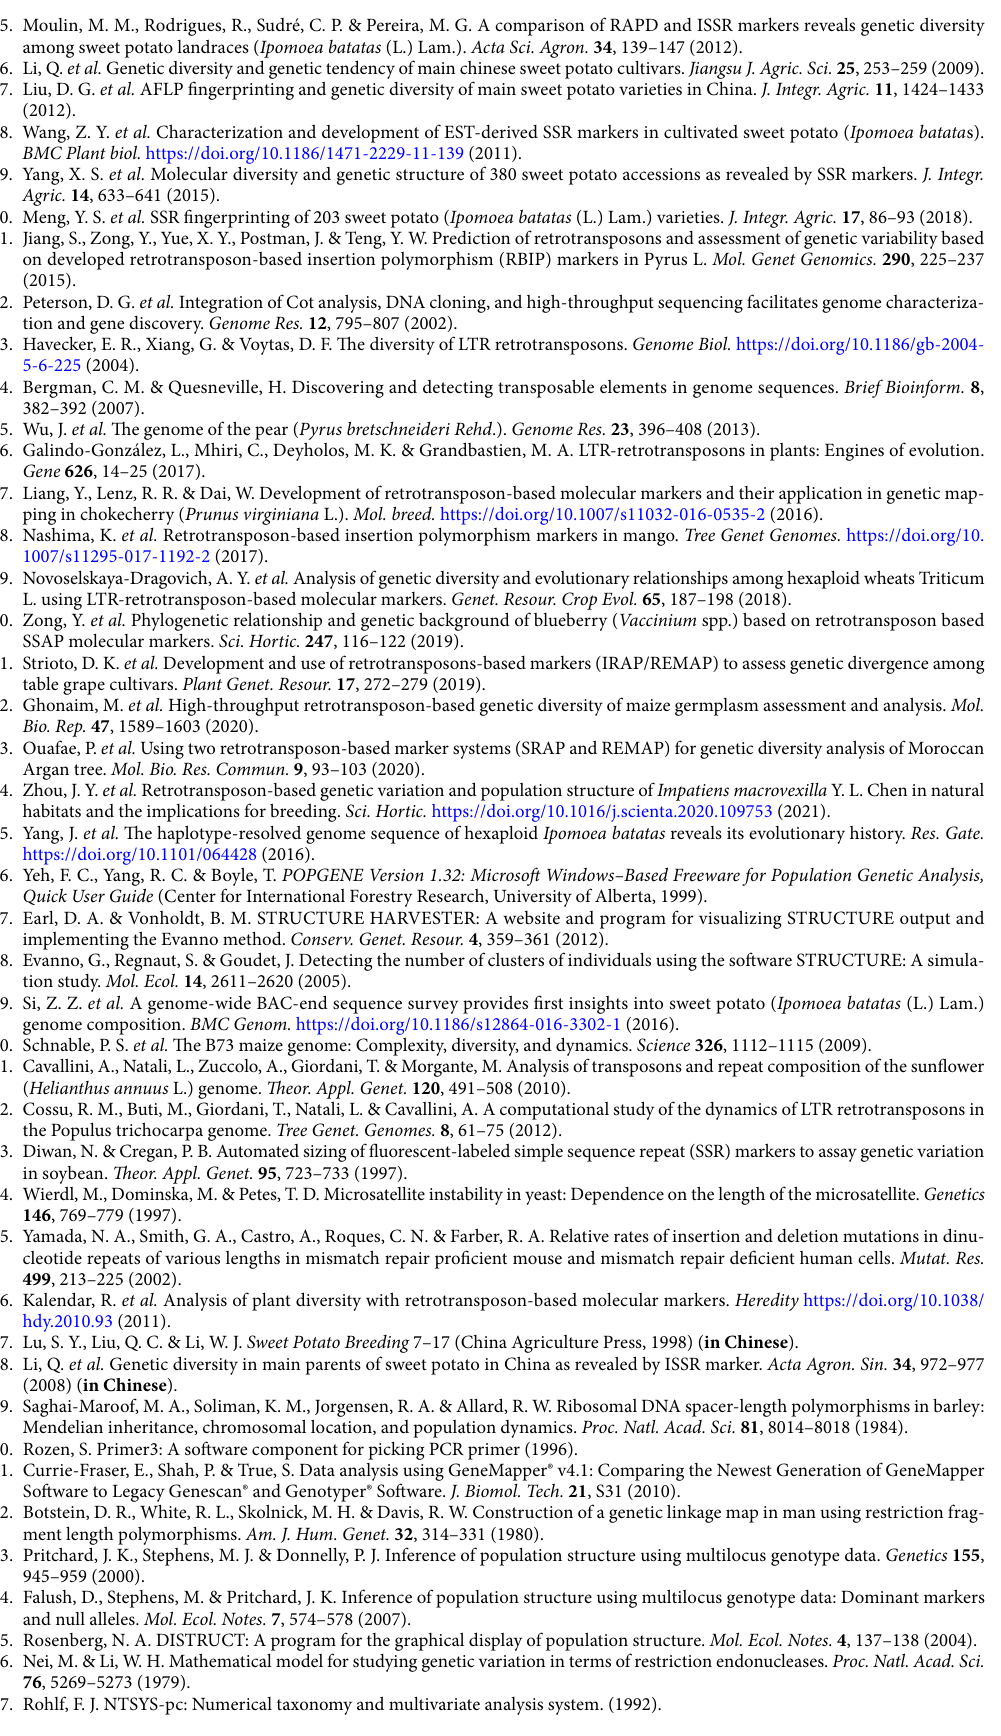
table grape cultivars. Plant Genet. Resour. 17 , 272–279 (2019). 22. Ghonaim, M. et al. High-throughput retrotransposon-based genetic diversity of maize germplasm assessment and analysis.